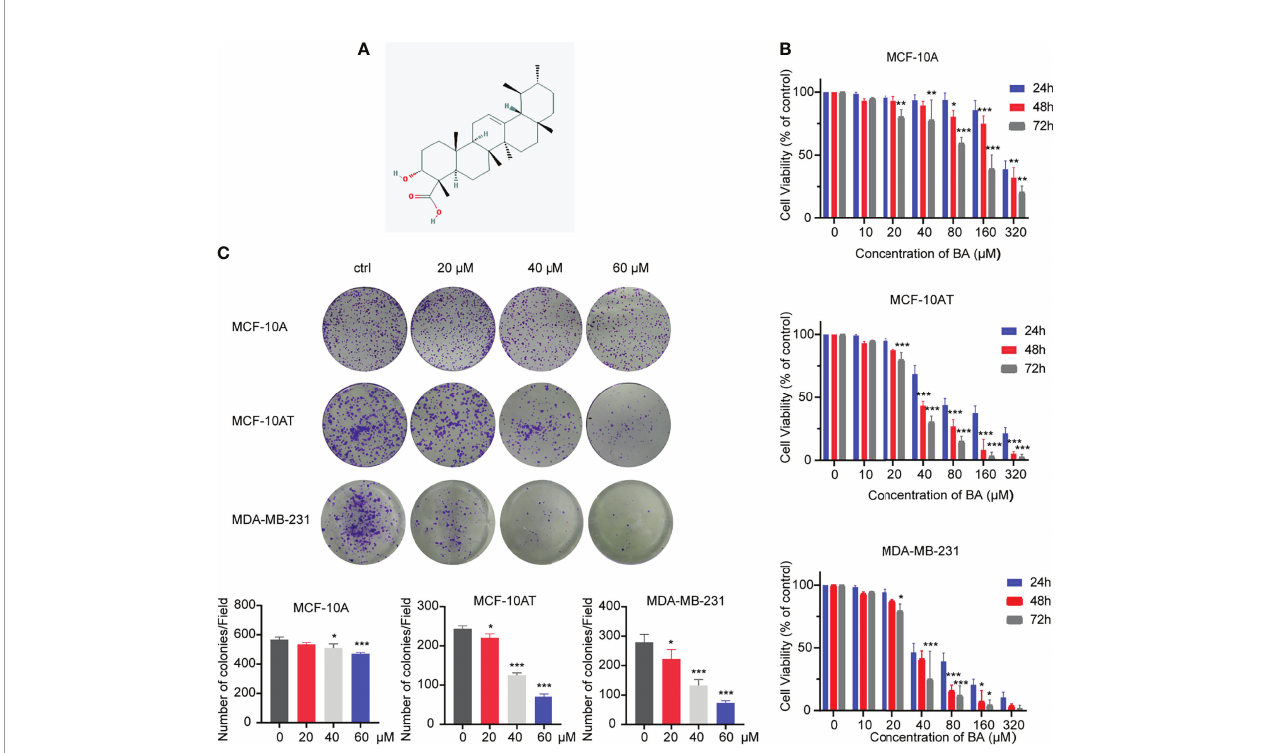
FIGURE 1 | b -BA inhibits cell proliferation in MCF-10AT and MDA-MB-231. (A) Chemical structure of b -BA. (B) Cell viability was detected by CCK8 assay following treatment with different doses of b -BA. Cells were treated with 0, 10, 20, 40, 80, 160, and 320 m M of b -BA for 24, 36 and 48 h, respectively. IC 50 values for each cell line at different time points were determined. (C) Colony formation assay for MCF-10A, MCF-10AT, and MDA-MB-231 treated with 0, 20, 40, and 60 m M of b - BA, respectively. Numbers of colonies were counted and shown below. *p < 0.05, **p < 0.01, and ***p <